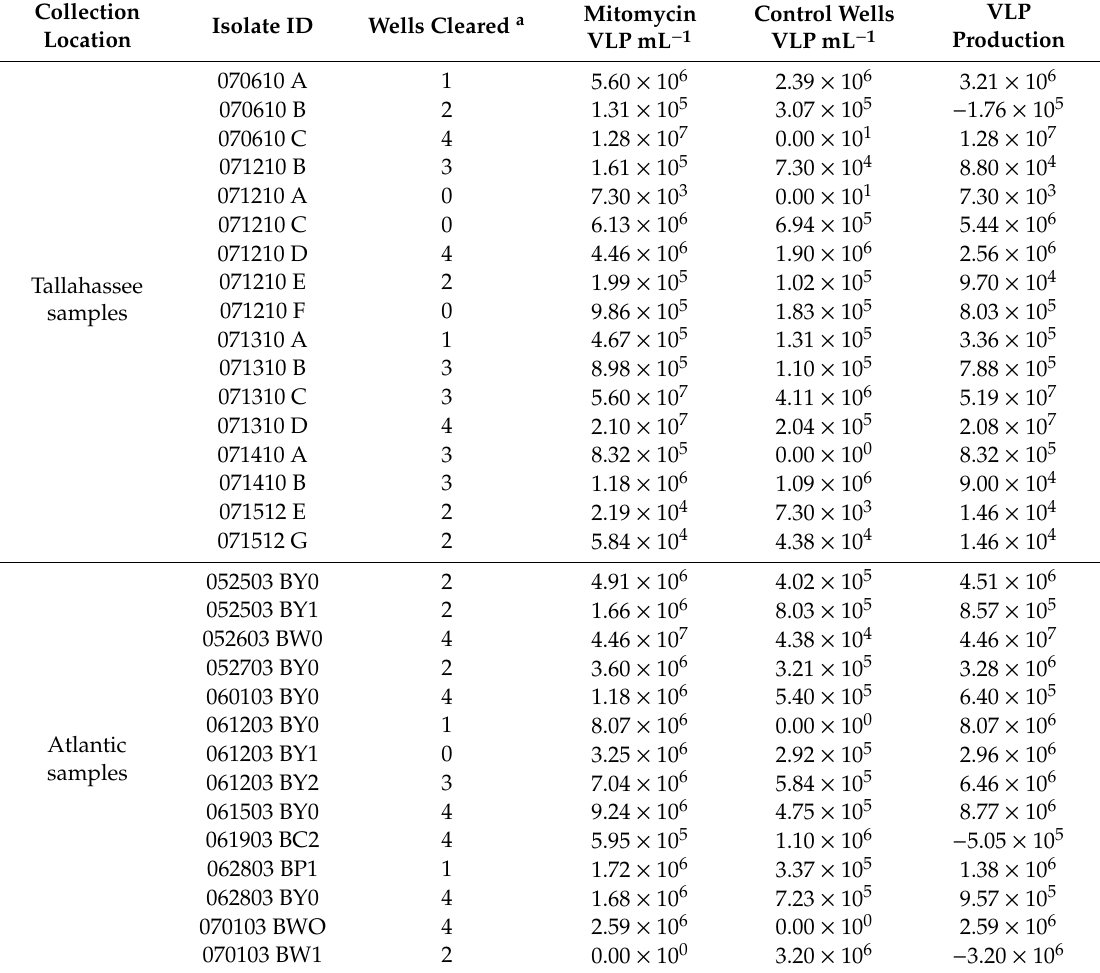
Table 3. Bacteriophage production (virus-like particles, VLP) per epifluorescent direct